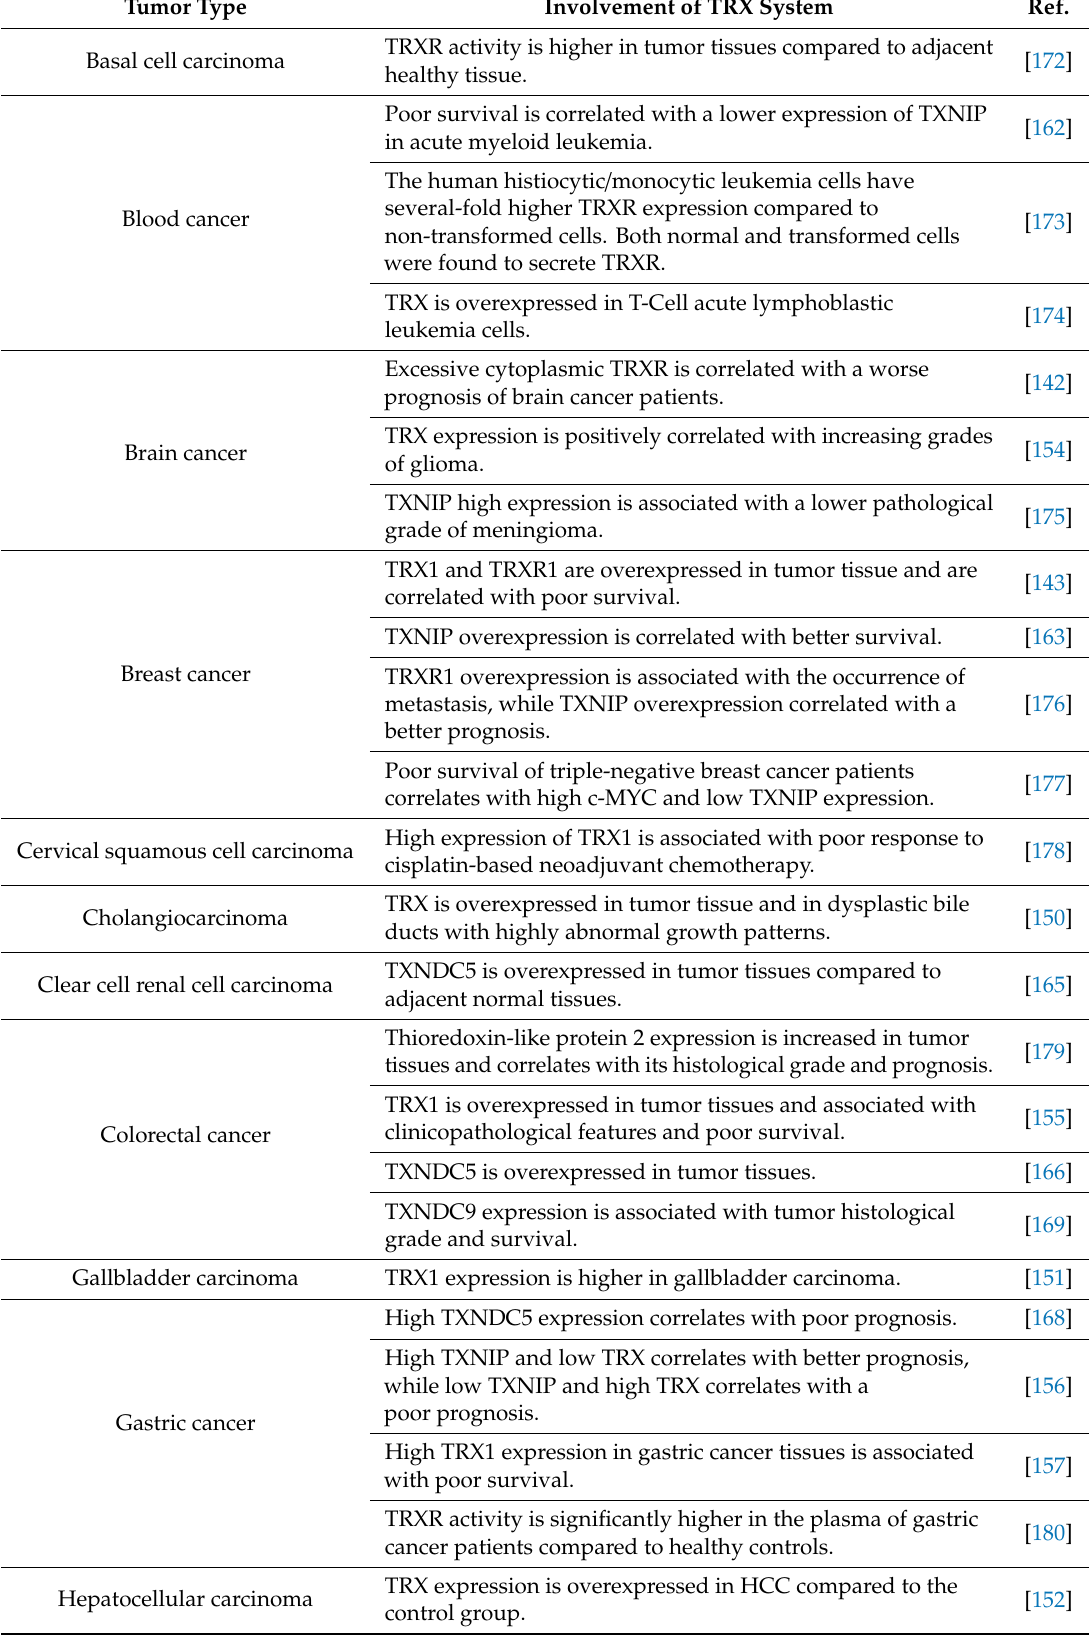
Table 2. The implication of the TRX system and TXNDC protein family in